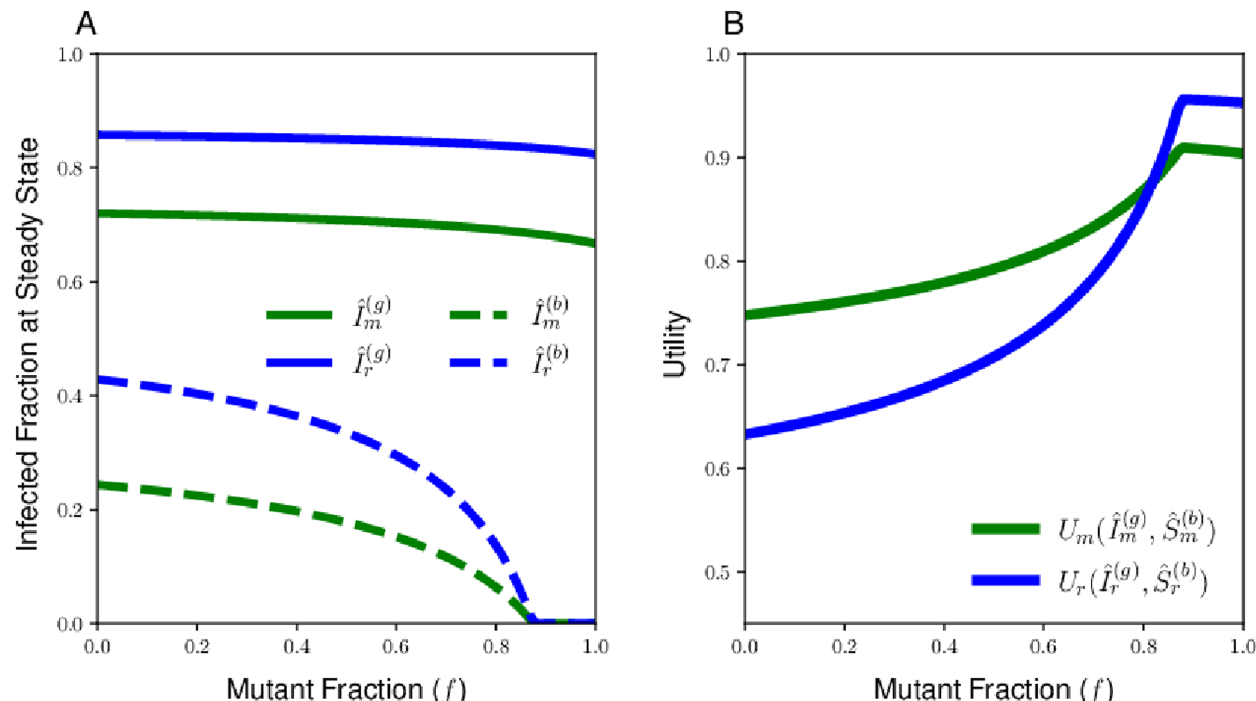
Fig 3. Endemic equilibria of the two contagions for the resident and mutant populations (A) and the Cobb-Douglas utility (B) for a case in which the resident and mutant sociality stategies lie on opposite sides of the social optimum. The utility for the resident strategy (blue curve) and the mutant strategy (green curve) intersect at a single fraction of mutants f , which is the equilibrium of the replicator equation at which the two types will coexist. The Cobb-Douglas utility has weight parameter α = 0.25, the relative infectiousness of the bad contagion is c = 0.25, and the resident and mutant reproduction numbers are given by R ð g Þ ¼ 7 and R ð g Þ ¼ 3 , r m